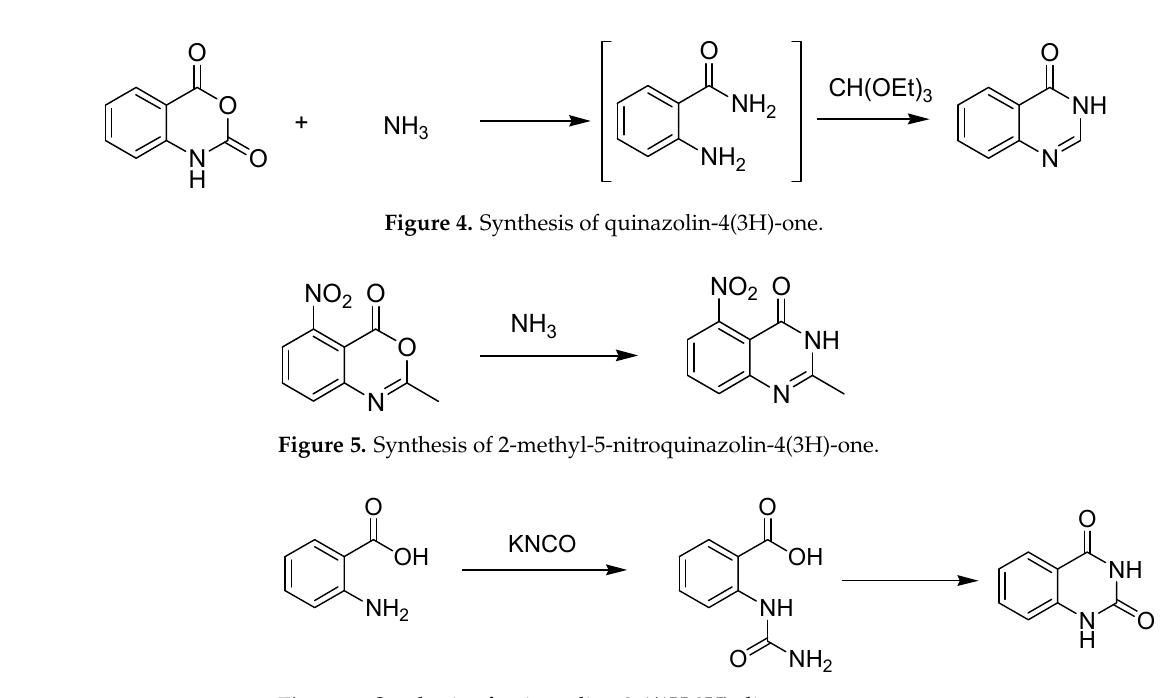
Figure 6. Synthesis of quinazoline-2,4(1H,3H)-dione.